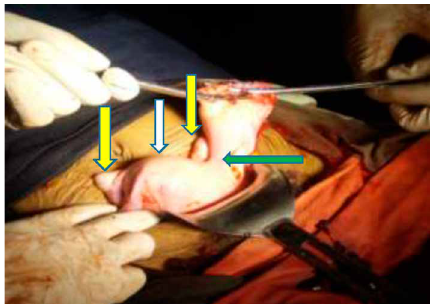
Figure 2: Uni-cornuate uterus (white arrow) with left side rudimentary horn (green arrow) attached to uterine body by dense fibro-muscular tissue. Ovaries are bilaterally visible (yellow arrows).